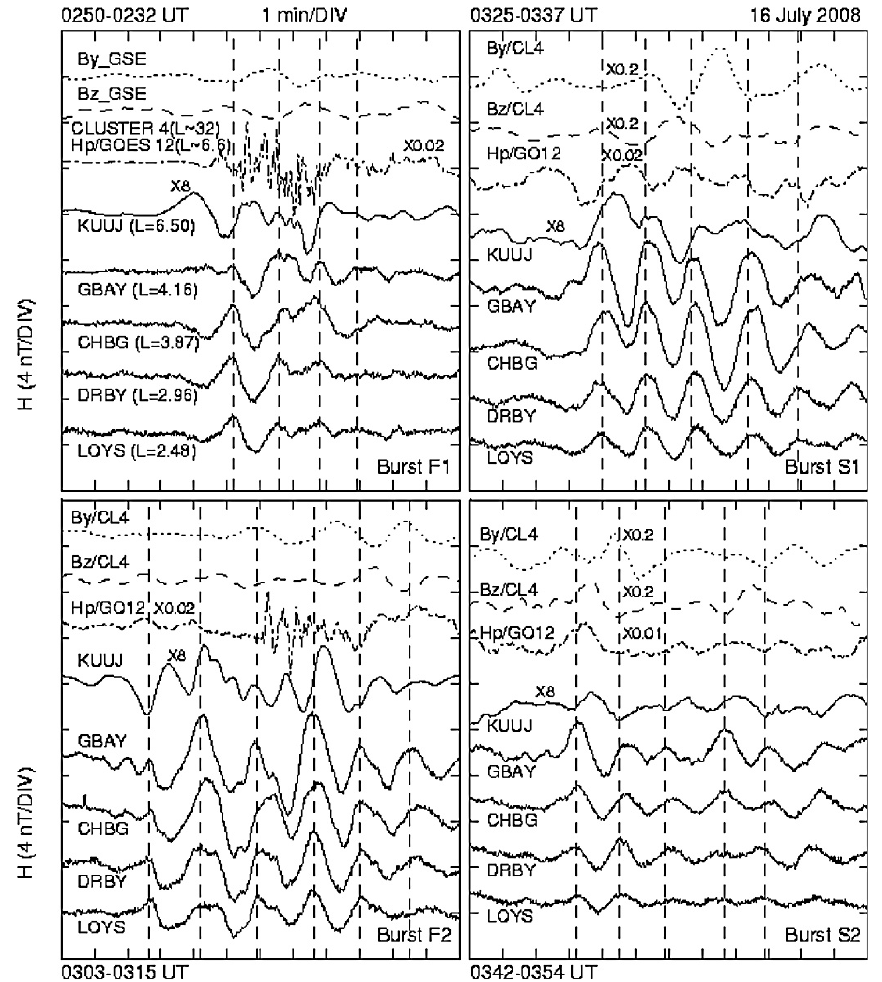
Fig. 15. The waveforms at the THEMIS ground stations along the East Coast of North America for four Pi2 bursts compared to magnetic fluctuations sensed by GOES 12 and CLUSTER 4 satellites. The solid traces denote the H-component at the THEMIS ground stations. The dot-dashed trace denotes the Hp component at GOES 12. The dotted and dashed traces denote the By GSE and Bz GSE components at CLUSTER 4, respectively. The vertical dashed lines denote the most same peaks in the waveforms seen by the THEMIS ground stations along the East